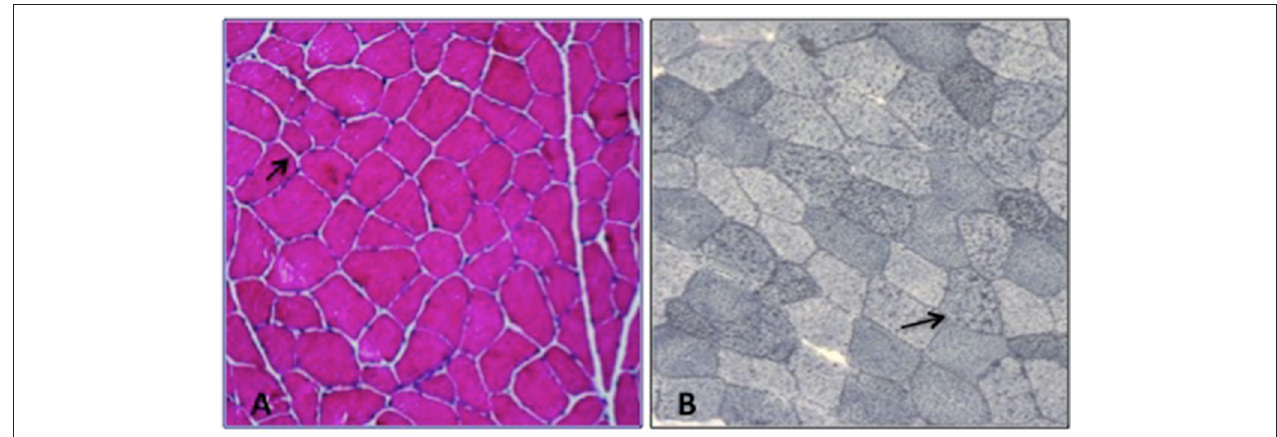
FIGURE 1 | Muscle biopsy; (A) H&E: increased fiber size variability, (B) Sudan Black: lipid storage in several myofibers